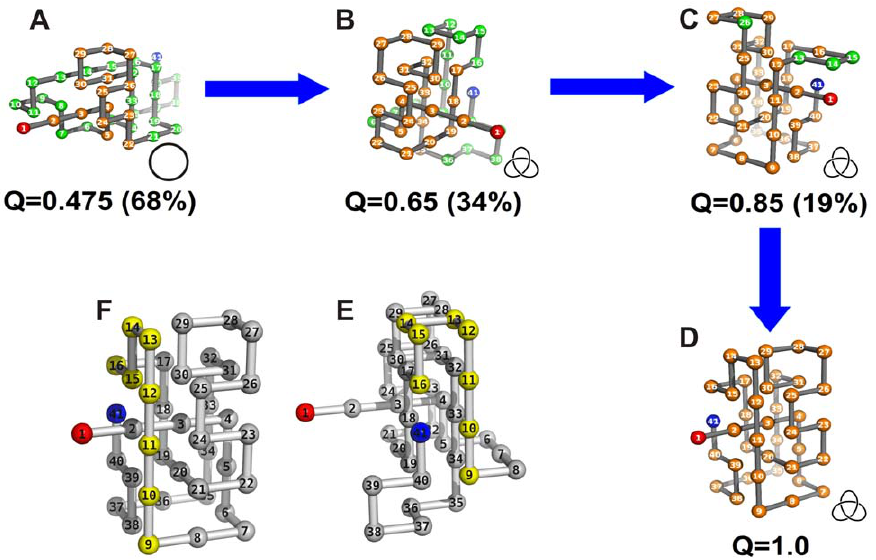
Figure 10. Knotting mechanism operating when the chain is surface tethered by the C-terminus. The conformations in the inner panel are the representative conformations with Q =0.65 (E) and native structure (F) where the chain segment 9–16 is highlighted. Tethering the protein at the C-terminus forces this segment to develop in a plane clearly behind the native plane.